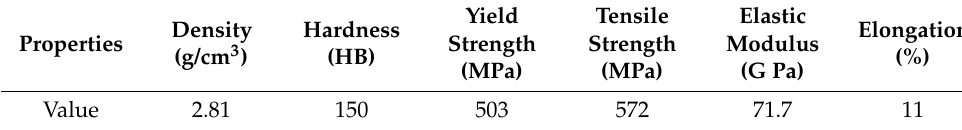
Table 3. Parameters of experimental system.